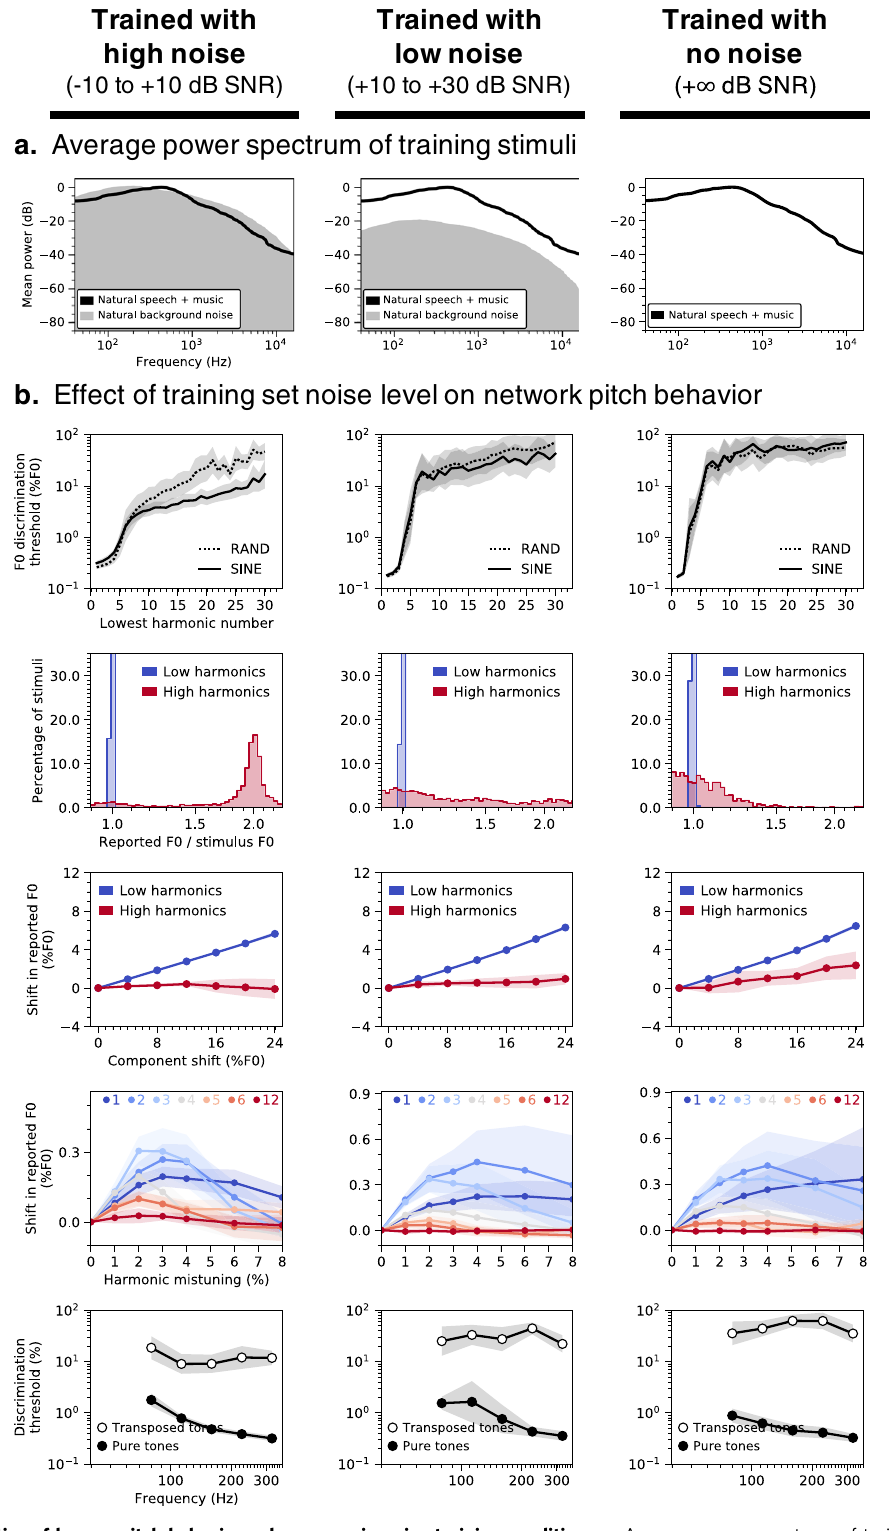
Fig. 8 Key characteristics of human pitch behavior only emerge in noisy training conditions. a Average power spectrum of training stimuli. Networks were trained on speech and music stimuli embedded in three different levels of background noise: high (column 1), low (column 2), and none (column 3). b Effect of training set noise level on network behavior in all fi ve main psychophysical experiments (see Fig. 2a – e): F0 discrimination as a function of harmonic number and phase (row 1), pitch estimation of alternating-phase stimuli (row 2), pitch estimation of frequency-shifted complexes (row 3), pitch estimation of complexes with individually mistuned harmonics (row 4), and frequency discrimination with pure and transposed tones (row 5). Lines plot means across the ten networks; error bars indicate 95% con fi dence intervals bootstrapped across the ten